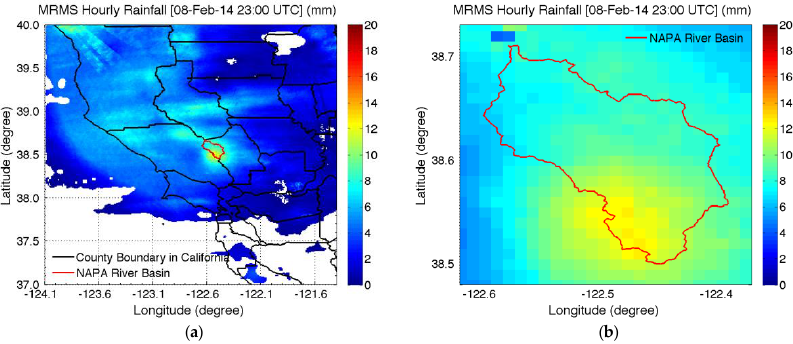
Figure 5. Radar-based gridded rainfall fields from Multi/Radar Multi/Sensor data: ( a ) Northern California Multi-Radar Multi-Sensor (MRMS) precipitation; ( b ) MRMS precipitation field for St. Helena Napa basin, CA.